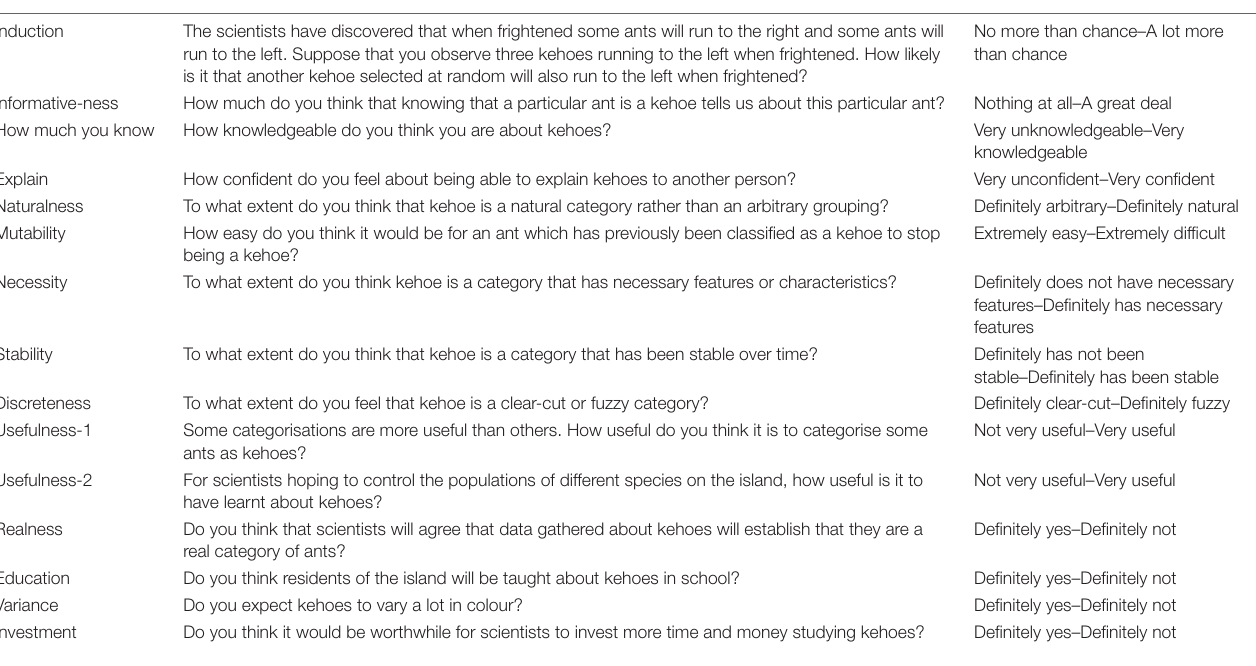
TABLE 4 | Fifteen concept appraisal questions used in Study